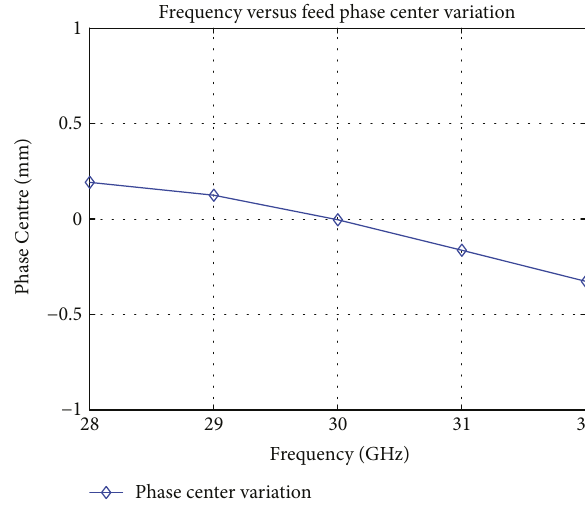
Figure 5: Simulated feed phase center versus frequency.